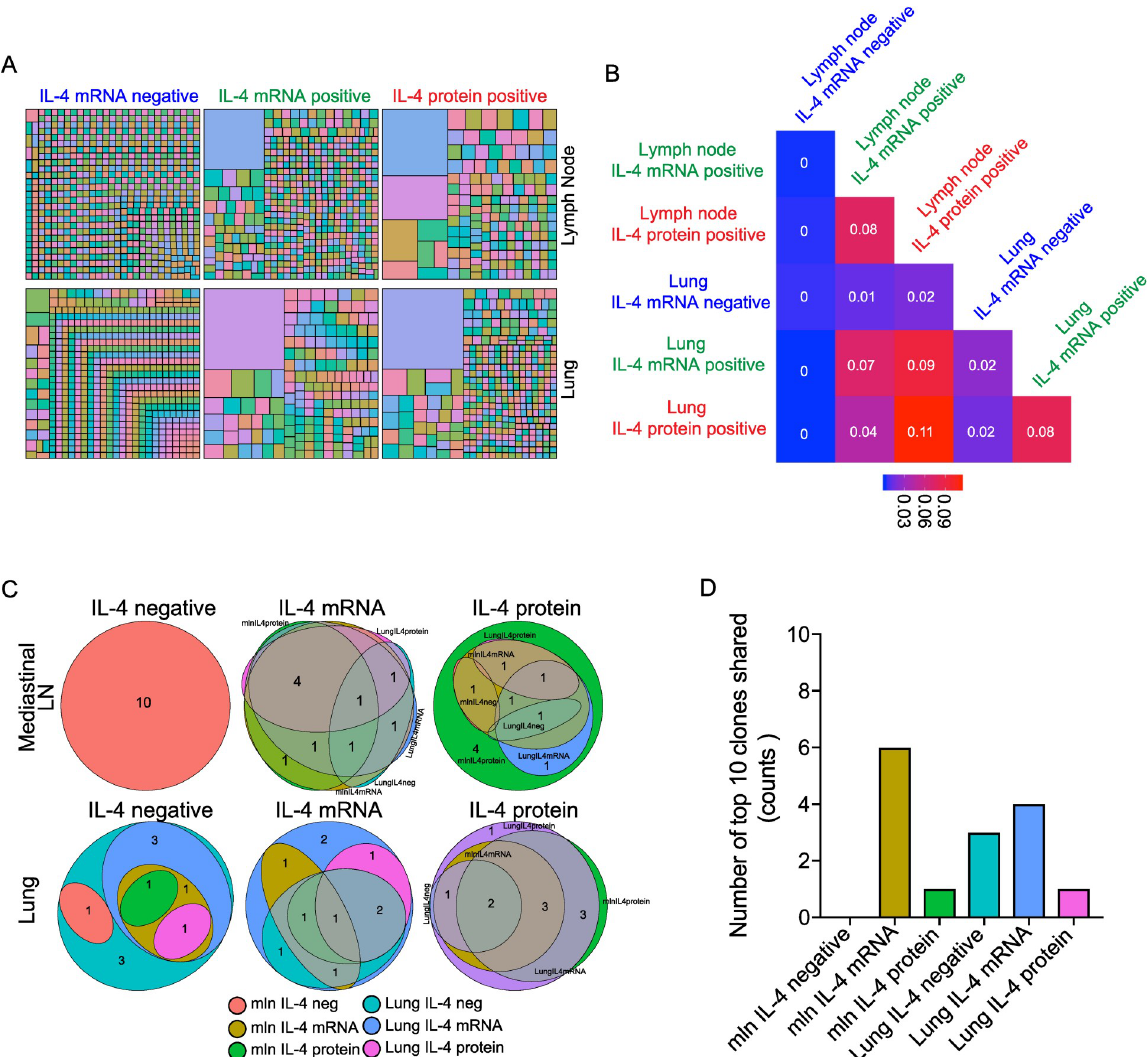
Fig 2. Single-cell sequencing of the T cell receptor repertoire reveals shared clonal origins among the most prevalent clonotypes in the lymph nodes and lung after helminth infection. The lung and mediastinal lymph nodes were harvested from an IL-4 4get-KN2 C57BL/6 mouse that was infected nine days prior with N . brasiliensis . The GFP + and GFP - CD4 + T cells were sorted and single-cell sequencing of the TCR α and β chains was performed. (A) Tree map showing clonal abundance of the top 792 clones in each of the indicated tissues. Each clone was assigned a random color and the size of the box represents its clonal abundance among the pool of clones sequenced in the indicated tissue. (B) Jaccard similarity coefficient matrix comparing the similarity of TCR- α / β sequences of IL-4 + and IL-4 - CD4 + T cells isolated from the mediastinal lymph node and lung. (C) Euler plots represent the overlap of the top 10 clones observed in each group of 6 groupings of T cells; number in each oval represents the number of top 10 clones that are present in other groups. (D) Bar graph shows the number of top 10 clones in each group that are also a part of the top 10 clones in other T cell